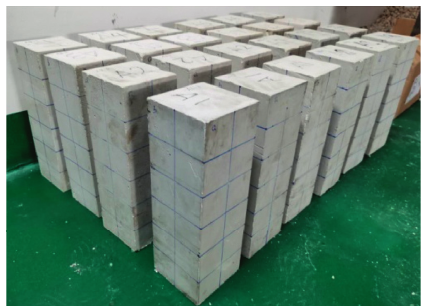
Figure 2: Specimens after demolding.